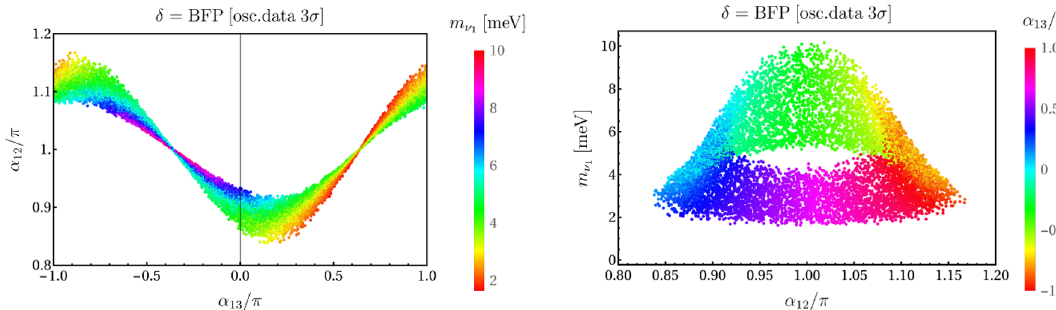
Figure 4 . Allowed parameter space for (cid:11) 12 , (cid:11) 13 and m (cid:23) 1 . Note that m (cid:23) 1 is shown in units of meV. Neutrino oscillation data was scanned over the 3 (cid:27) uncertainties, except (cid:14) which is taken at its best (cid:12)t value for